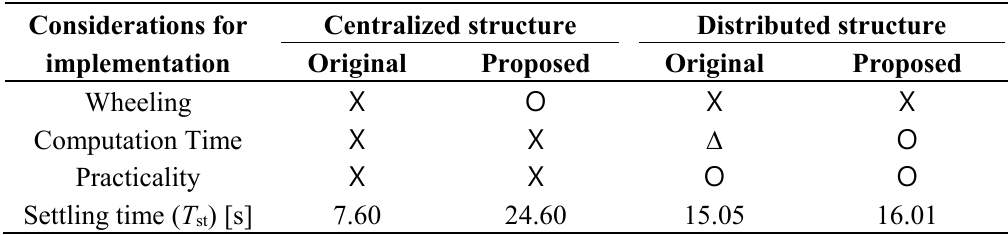
Table 6. Structure-dependent MPC-based